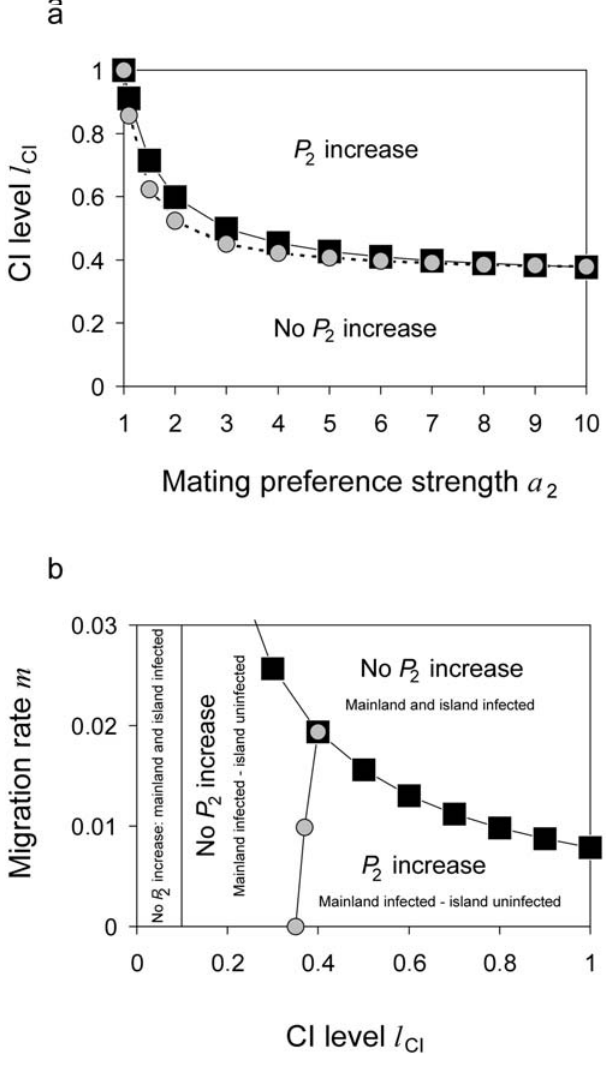
Figure 5. Thresholds for the spread of the mating preference mutant. Graph (a): The parameter plane spanned by the preference strength and the CI level consists of two areas. For low levels of CI, P 2 cannot spread no matter how strong the mating preference is. For CI levels above a certain threshold, however, P 2 spreads on the island. Black squares indicate simulation results, gray circles values determined by formula (17). Graph (b): The parameter space spanned by the CI level and the migration rate consists of four areas. First, if l CI , f then mainland and island are uninfected and P 2 cannot spread. Second, if m . m c then both mainland and island are infected and P 2 cannot spread. Third and fourth, if l CI . f and m , m c then P 2 can spread if the CI level is above a threshold but cannot if the CI level is below. Parameters are f =0.1 in both graphs, m =0.001, s =0.1 in (a) , and a 2 =10, s =1 in (b) .